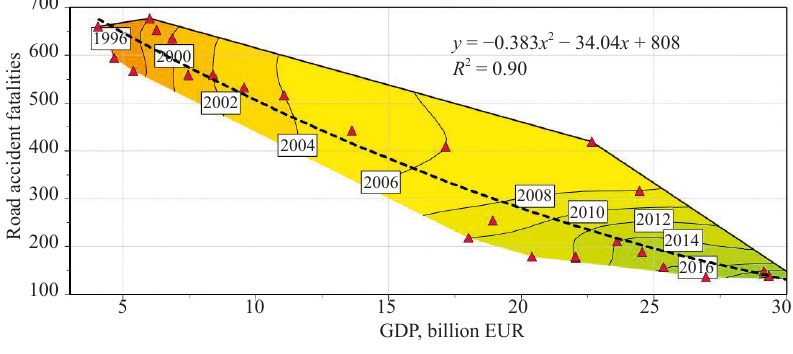
Figure 12. Road accident fatalities and GDP in Latvia from 1996 to 2020